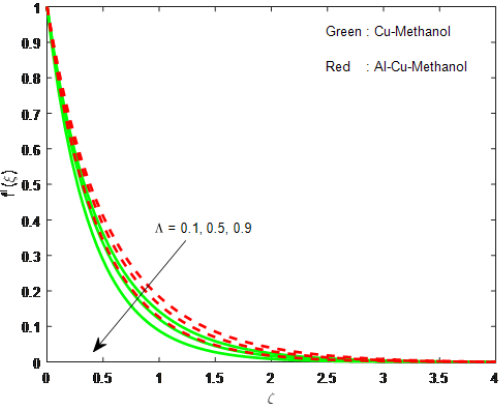
Fig. 11: Impression of Λ on f (cid:48) ( ξ )